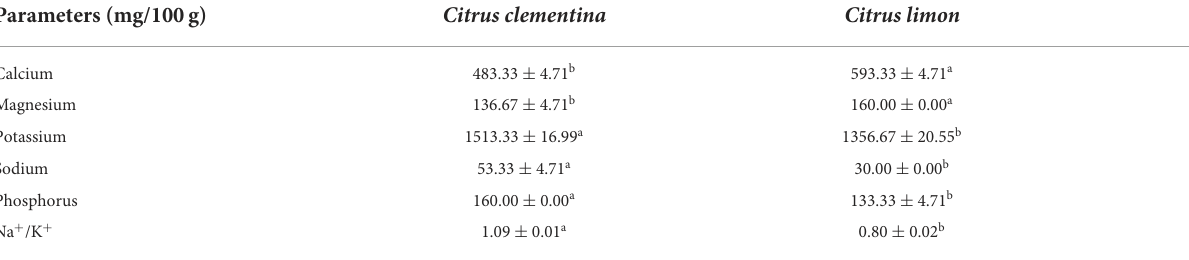
TABLE 2 Macro elemental composition (mg/100g) of whole Citrus clementina and Citrus limon.